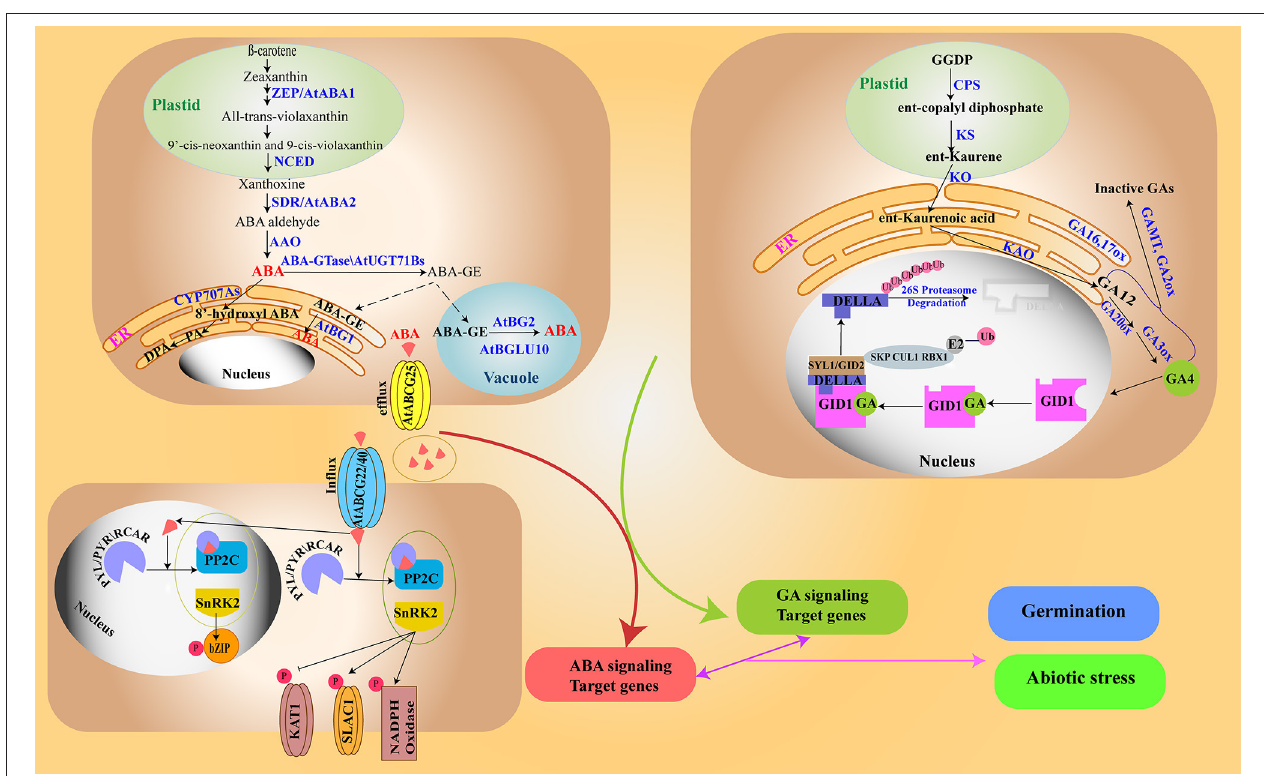
FIGURE 1 | ABA and GA metabolism and signaling/ABA is synthesized from carotenoids in a series of reactions in the plastids and cytoplasm (top left). ABA is catabolized to form phaseic acid. ABA transport occurs through different transporters, and ABA elicits distinct signaling cascades (in the nucleus and cytoplasm) (bottom left). GA biosynthesis starts from GGDP in the plastid and a portion of it is catabolized to inactive forms (top right). In the GA signaling pathway, GA causes destruction of DELLAs (negative regulator of GA) via the 26S proteasome machinery. The two signaling pathways crosstalk to regulate seed germination and abiotic stresses (bottom